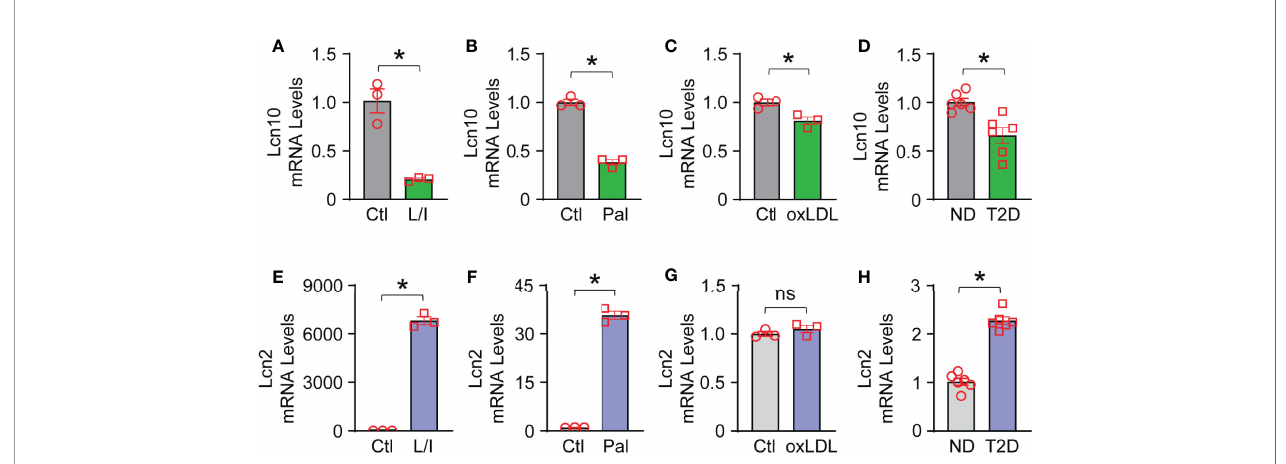
FIGURE 1 | Gene expression of Lcn10 and Lcn2 in macrophages. BMDMs were treated with LPS (10 ng/ml) + IFN- g (10 ng/ml), palmitate (0.5mM) and oxidized Low-Density Lipoprotein (10 µg/ml) for 12 hours, respectively. mRNA levels of Lcn10 (A – C) and Lcn2 (E – G) were measured by qRT-PCR (* P < 0.05, n = 3 samples per group). (D, H) Cardiac macrophages were isolated from the hearts of T2D mice, and gene expression of Lcn10 (D) and Lcn2 (H) were determined through qRT- PCR analysis (* P < 0.05, n = 6 mice per group). All data are presented as mean ± SEM and analyzed by student ’ s t-test. Ctl, control; L/I, LPS + IFN- g ; Pal, palmitate; oxLDL, oxidized Low-Density Lipoprotein; ND, non-diabetic; T2D, type 2 diabetes; ns, non signi fi